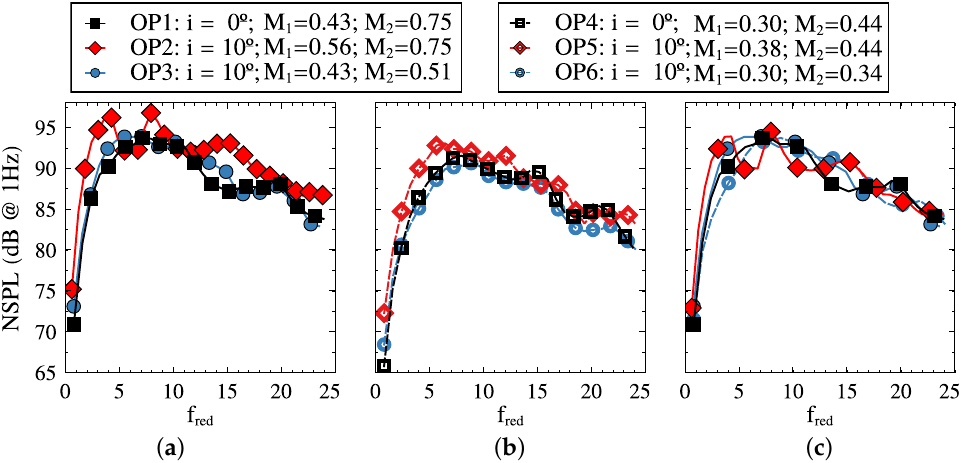
Figure 12. Inlet NSPL for different between operating points. ( a , b ) compare respectively the results of OP1-3 and OP4-6. ( c ) shows the NSPL of OP1-3 and 6 scaled with the inlet Mach number squared, M 2